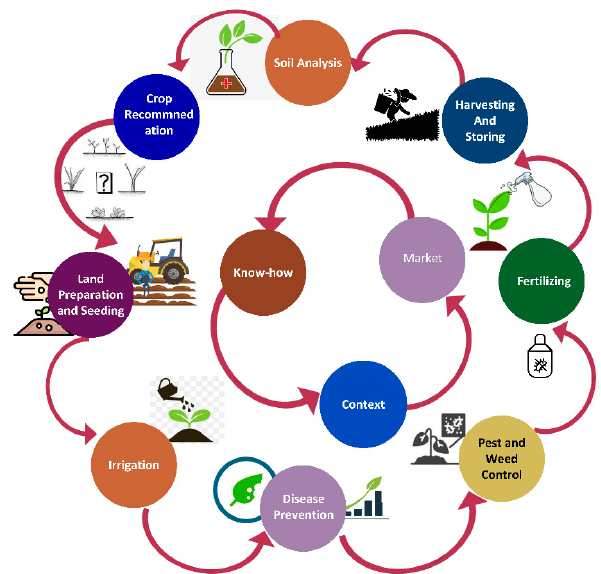
Figure 1. Agriculture